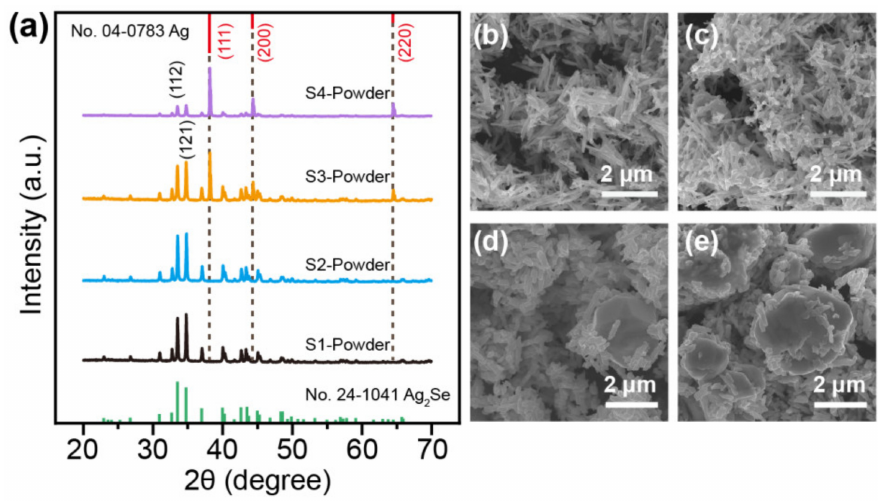
Figure 1. Characterisation of samples 1–4. ( a ) XRD patterns and ( b – e ) SEM images of the sample 1–4